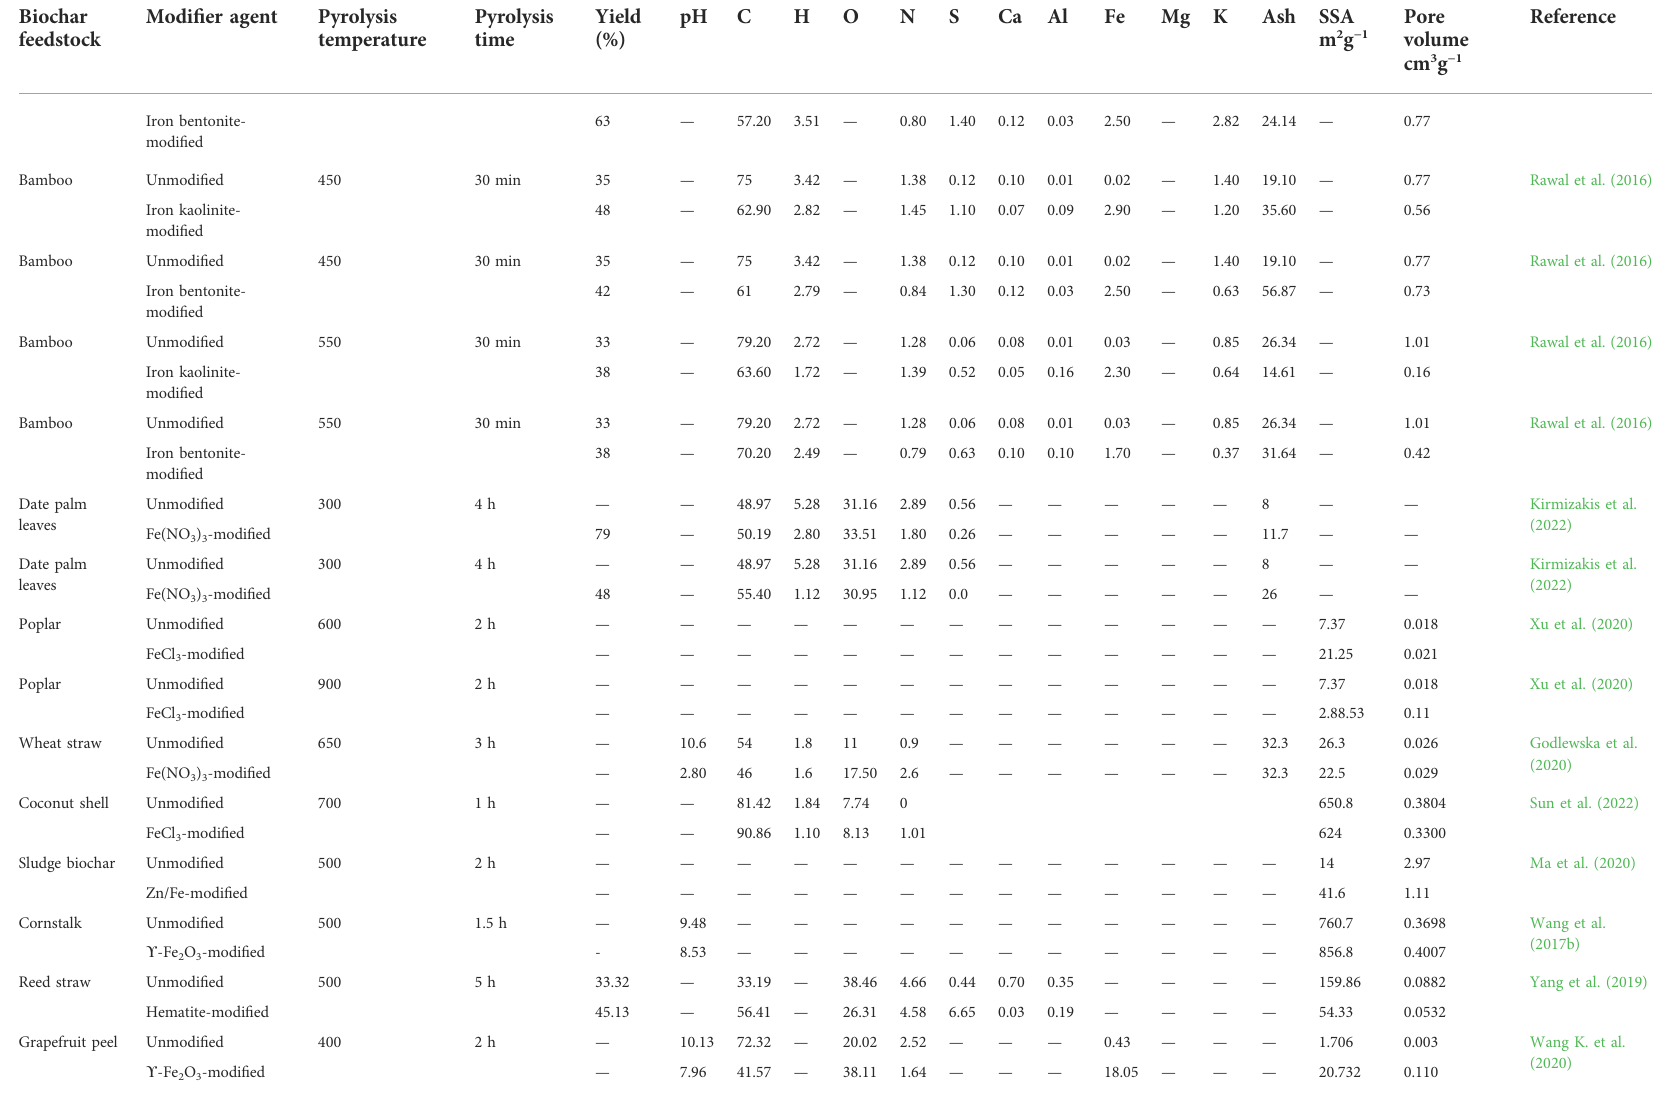
TABLE 3 ( Continued ) Properties of engineered biochar-based composite synthesized from various